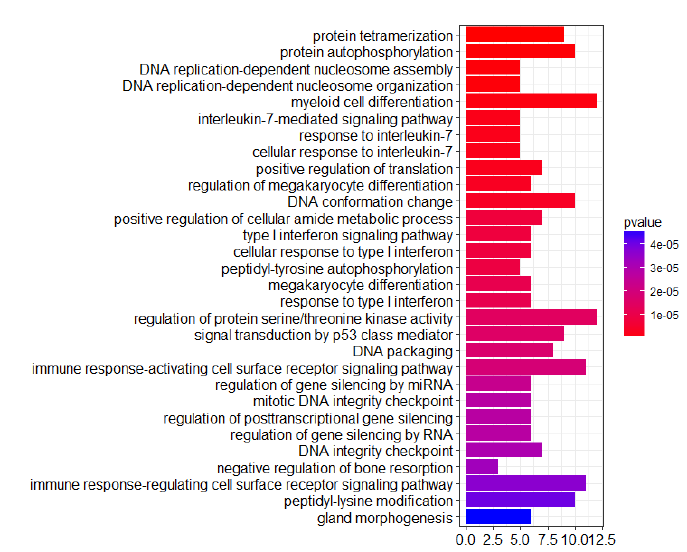
Figure 4. GO functional analysis (biological processes) of the top 100 genes of the PheWAS-Rank gene list (Table S4) ( p .adjust < 0.05). The abscissa represents the GeneRatio. GO: Gene Ontology.